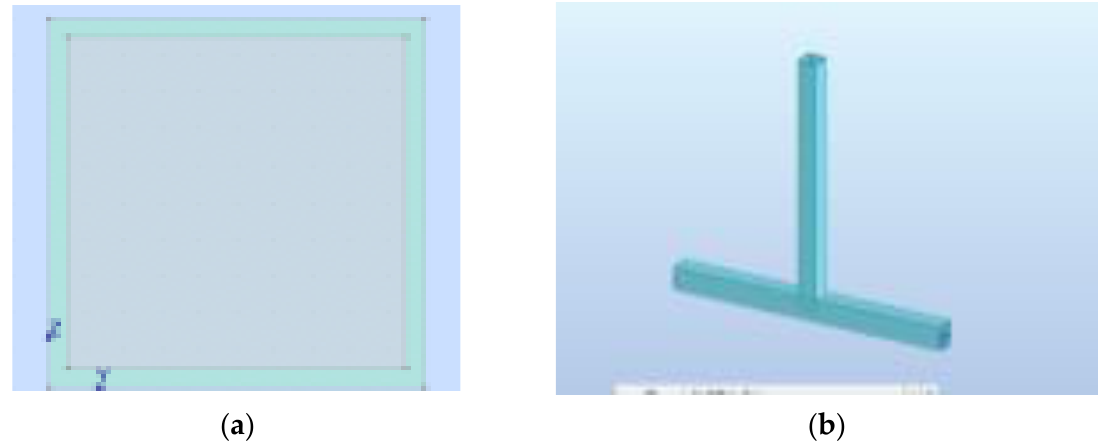
Figure 16. Creation of GFRP sections. ( a ) Composite section; ( b ) modeling of beam-column in RSA.